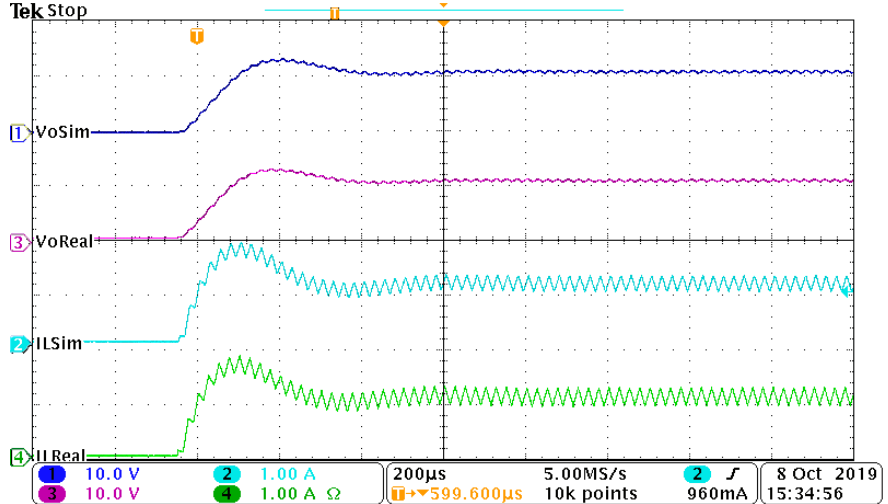
Figure 17. Output signals of the real converter and HIL simulation, simulated voltage (Channel 1), simulated current (Channel 2), real voltage (Channel 3), and real current (Channel 4).